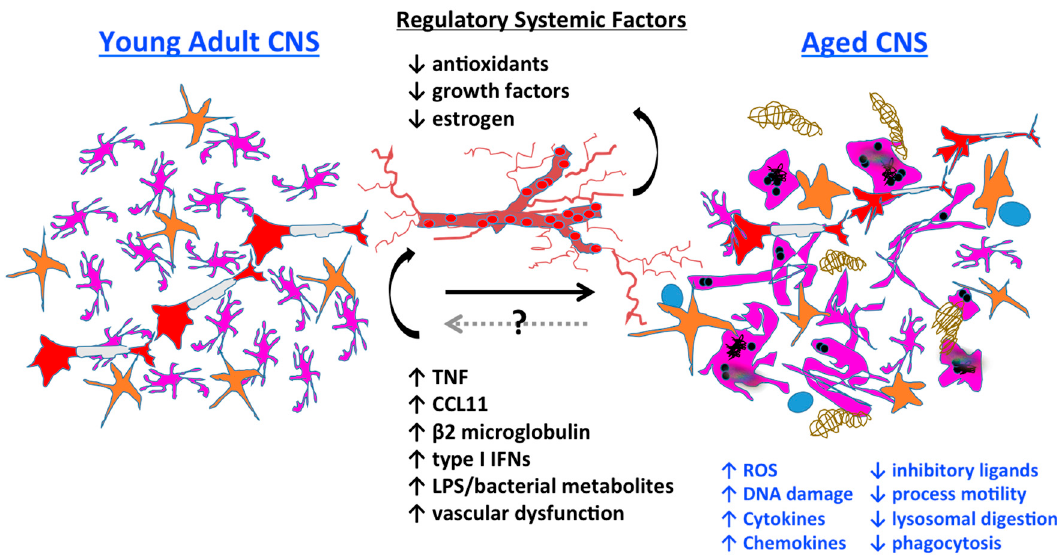
Figure 1. The impact of aging on microglia function and its systemic regulation. Young microglia (in pink) gradually transition from a ramified morphological state to a deramified, spheroid formation with abnormal processes with chronological age. Several cytoplasmic features are hallmarks of microglial senescence including increased granule formation, autofluorescent pigments such as lipofuscin, and process fragmentation. Age-related neuronal loss (in red) reduces the overall level of immunoinhibitory molecules (e.g., CD200, CX3CL1) required to maintain microglia in a quiescent state. Basal increases in inflammatory signaling are associated with enhanced reactive oxygen species (ROS) production which results in the generation of free radicals, lipid peroxidation, and DNA damage. This positive feedback loop is further compounded by defects in lysosomal digestion and autophagy, resulting in the potentially toxic buildup of indigestible material. Concurrent reductions in process motility and phagocytic activity lead to decreased immune surveillance and debris clearance, resulting in plaque formation (in brown). In turn, microglia activation triggers astrocyte activation (in orange) and promotes the recruitment of T cells (in blue) into the aging brain. These pathological features of microglial aging are highly influenced by the systemic environment. Diminished ( ↓ ) levels of circulating anti-aging factors in conjunction with increased ( ↑ ) concentrations of pro-aging factors are critical drivers of microglial senescence. For example, diminished estrogen levels in older (menopausal) females are associated with elevated expression of macrophage-associated genes in the brain. Therapeutic interventions intended to increase anti-aging factors and decrease pro-aging factors appear to be able to halt or delay microglia aging, enhance neurogenesis, and improve cognitive function.